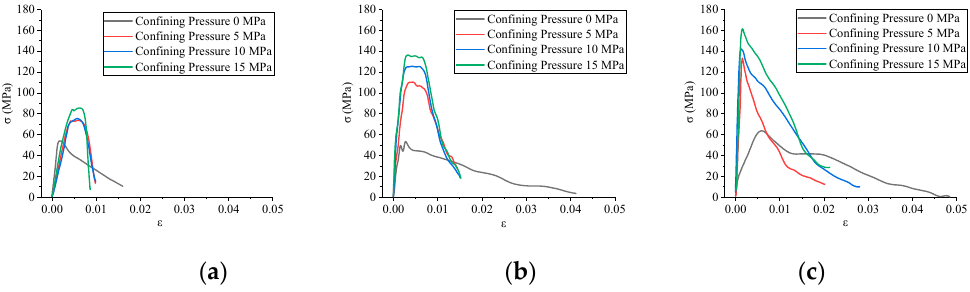
Figure 7. Stress–strain curves of specimens under different impact velocities and confining pressures. ( a ) Impact velocity: 5.4 m/s; ( b ) impact velocity: 8.8 m/s; and ( c ) impact velocity: 11.3 m/s.